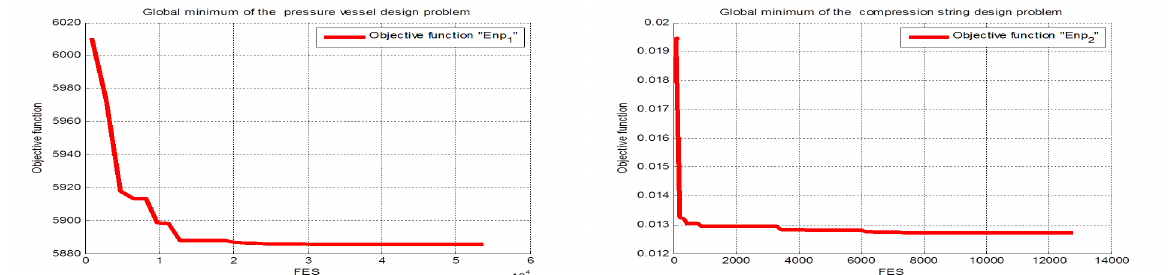
Figure 8. Convergence graph for engineering problems (Engp1 and